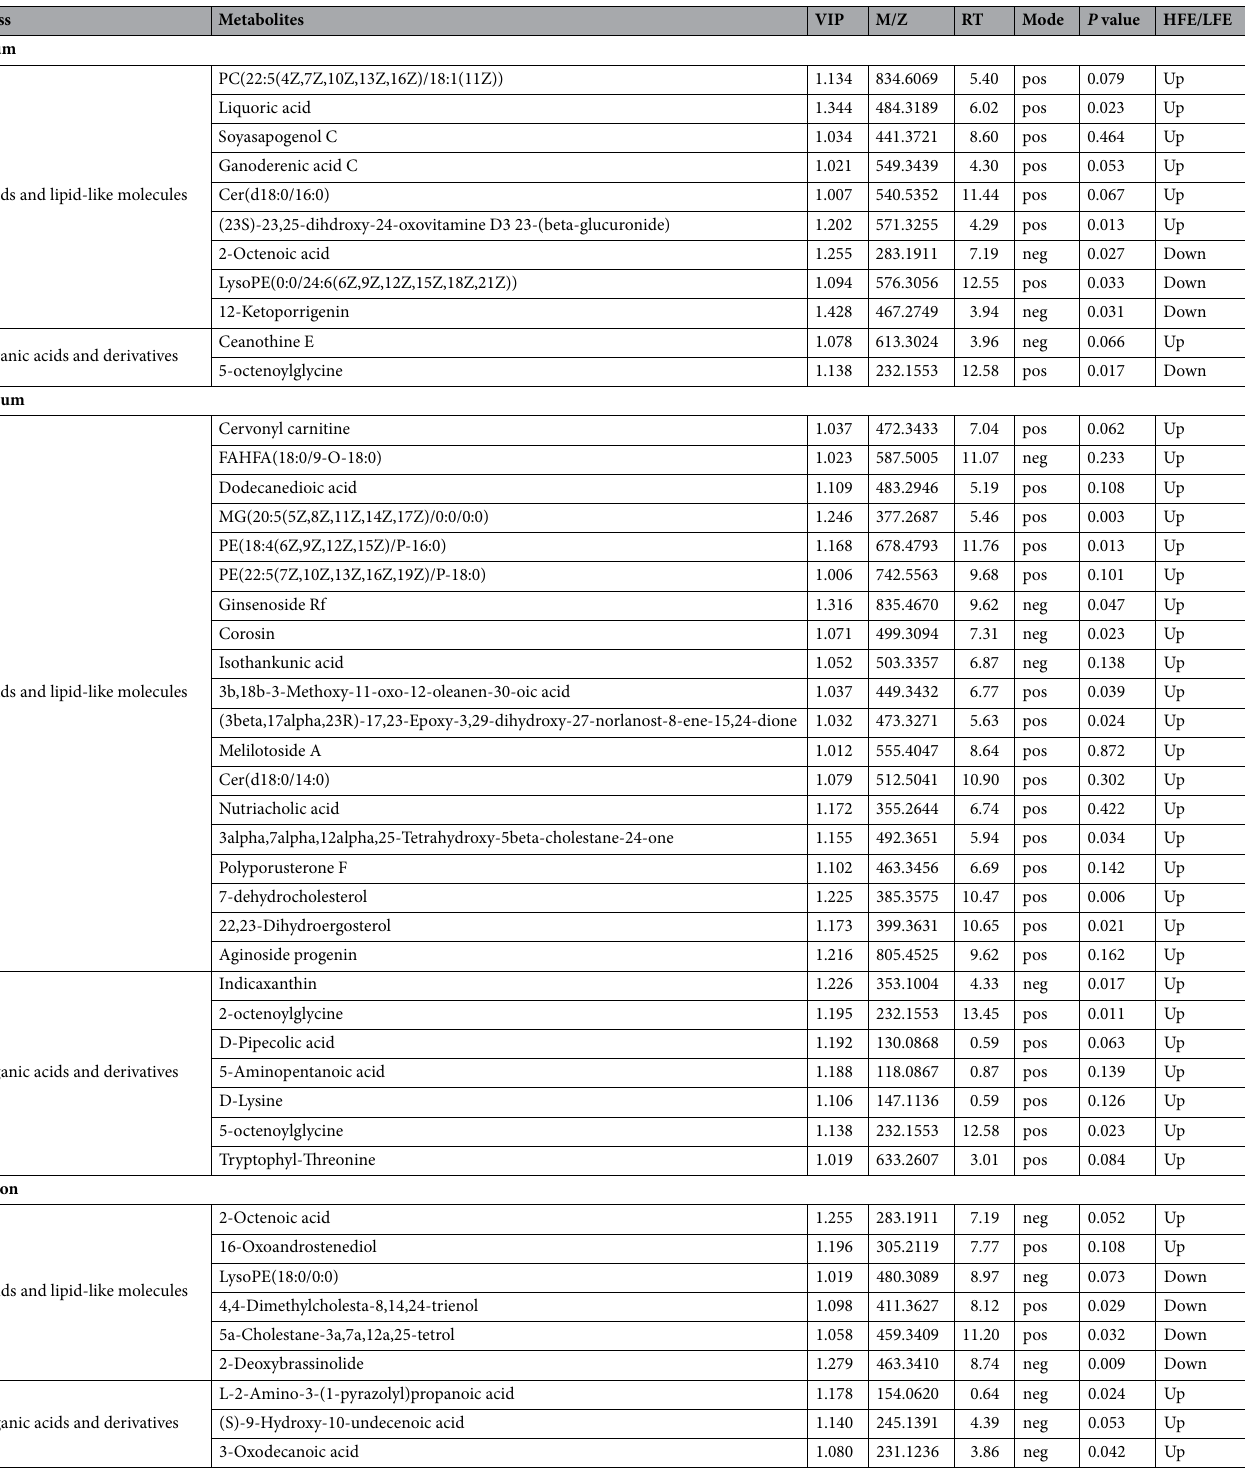
Table 2. Statistics of differentially accumulated lipids and organic acids in the high- and low-FE groups. M/Z mass-to-charge ratio, RT retention time, VIP variable importance in projection